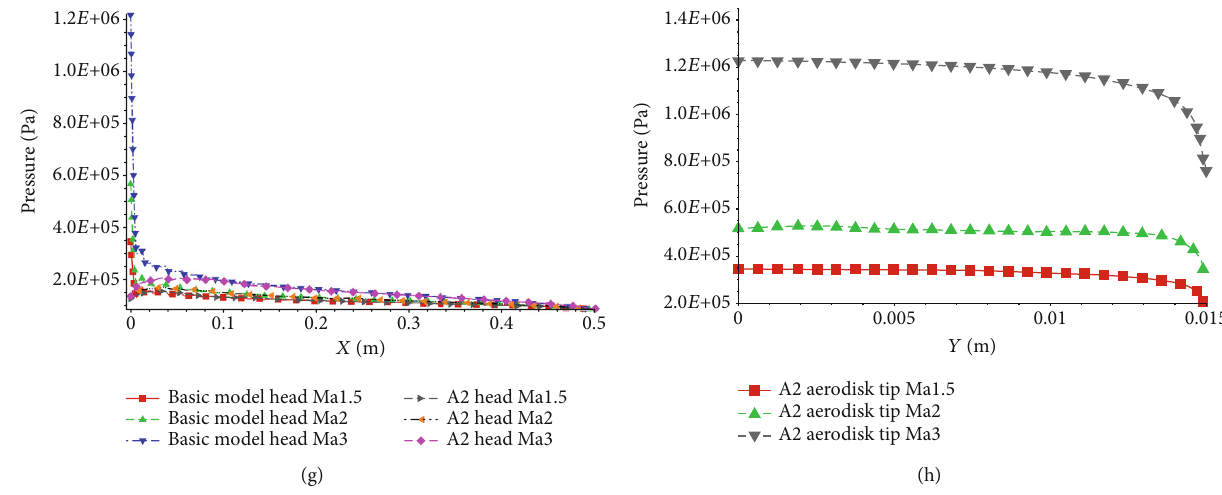
Figure 12: The fl ow fi eld feature of the A2 and basic model at three Mach numbers. (a) Pressure contour of the basic model at Mach number 1.5. (b) Pressure contour of the basic model at Mach number 2. (c) Pressure contour of the basic model at Mach number 3. (d) Pressure contour of A2 at Mach number 1.5. (e) Pressure contour of A2 at Mach number 2. (f) Pressure contour of A2 at Mach number 3. (g) Pressure curves of A2 head and basic model at three Mach numbers. (h) Pressure curves of A2 aerodisk tip at three Mach